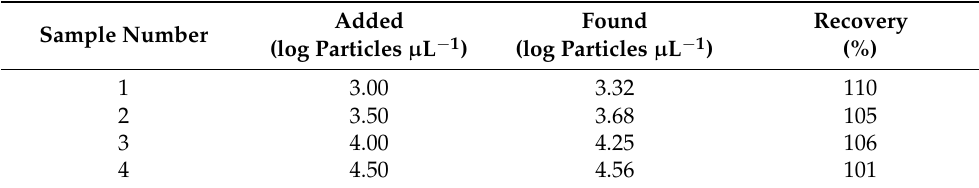
Table 1. Exosome analysis in serum using the